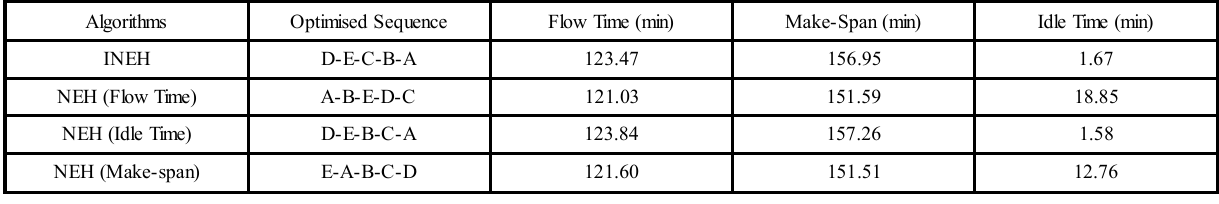
TABLE 7. OPTIMIZED SEQUENCE OBTAINED FROM VARIOUS